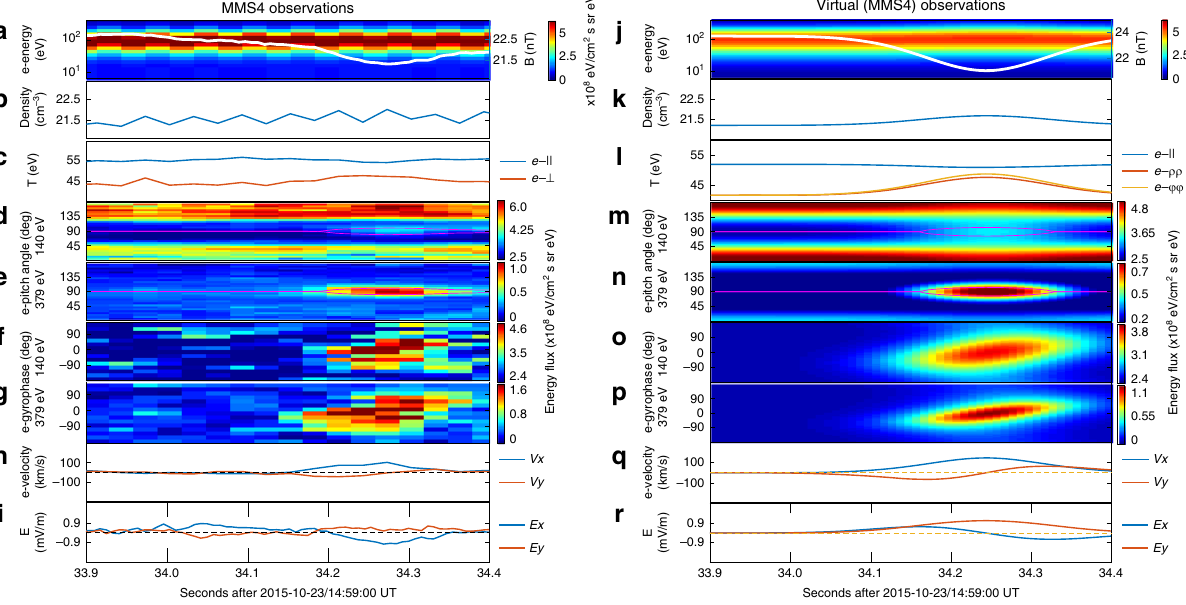
Fig. 4 The MMS4 observations and virtual spacecraft observations of the electron-scale magnetic cavity. Panels a – r are in the same format as in Fig.